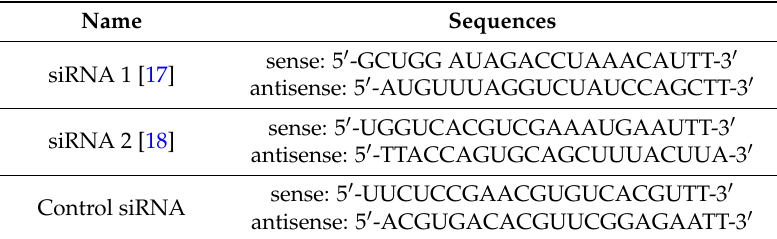
Table 1. The sequences of the two different TXNIP